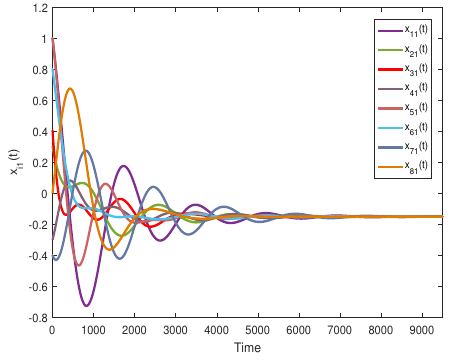
Figure 2. The states of x i 1 ( t ) .